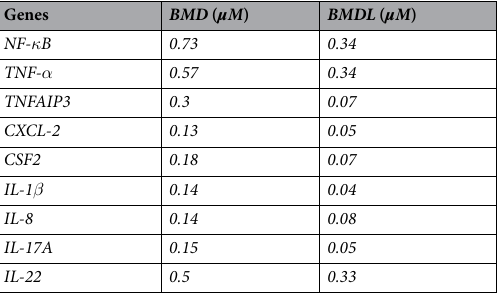
Table 1. Benchmark doses for the intestinal up-regulation of the NF- κ B transcription factor and pro- inflammatory cytokine gene expression by